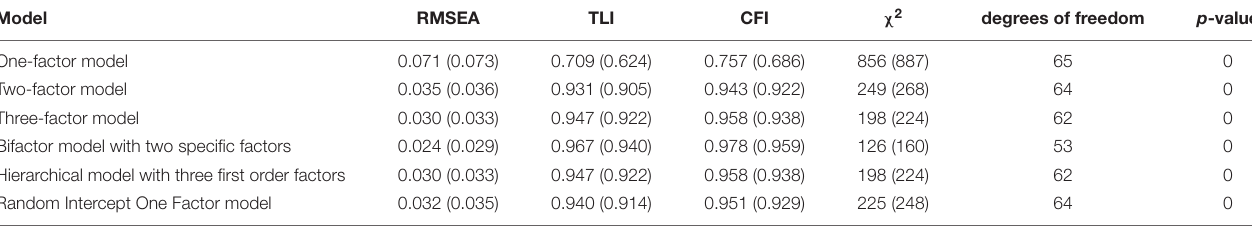
TABLE 5 | CFA and RIIFA comparison of standard fit statistics (robust is given in parenthesis, n = 2,407). Model